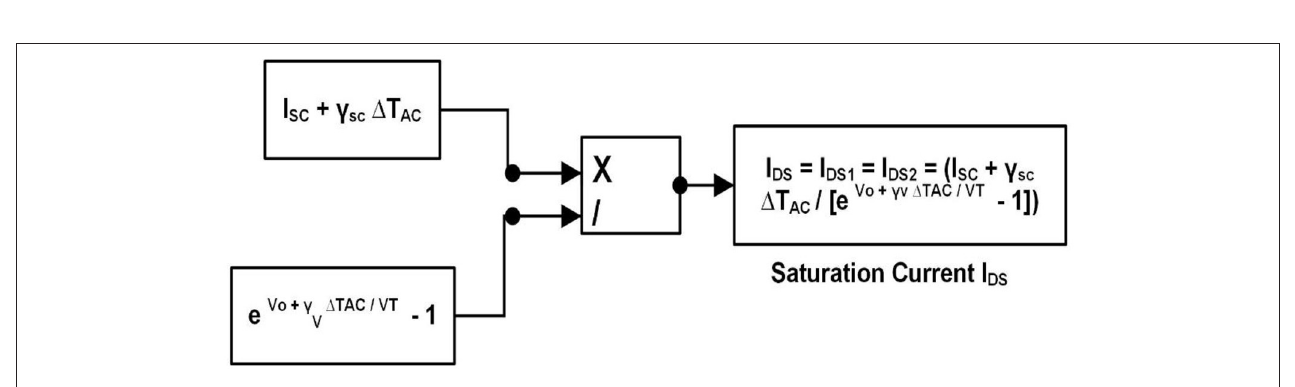
FIGURE 5 | Saturation current (I DS ) of proposed two-diode model.